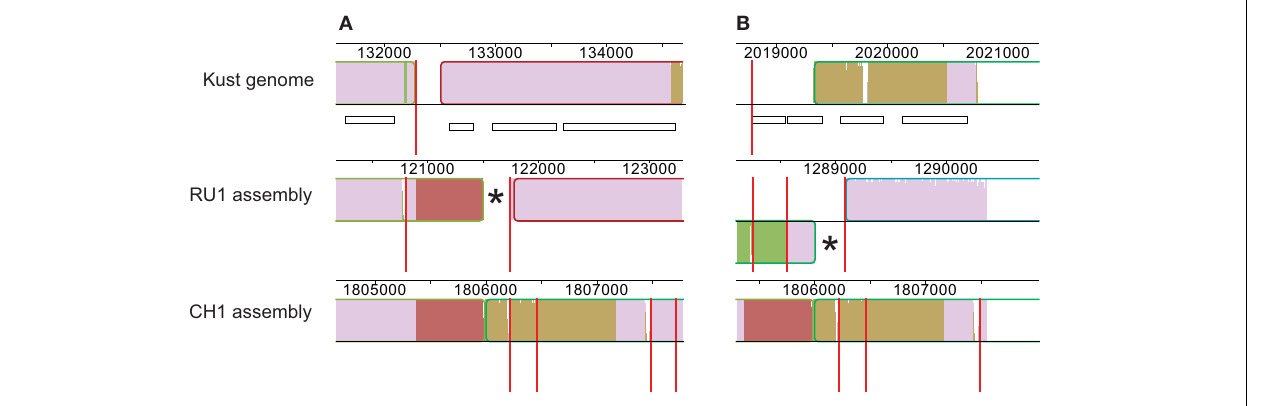
FIGURE 3 | Contigs in RU1 and CH1 bridging the gap between contigs KustB and KustE of the Kust genome. The sequence missing from the Kust genome is indicated in red. Red vertical lines mark contig boundaries, white rectangles represent genes, numbers indicate position on the genome.The (*) in both panels marks sequence of the RU1 alignment that is identical to